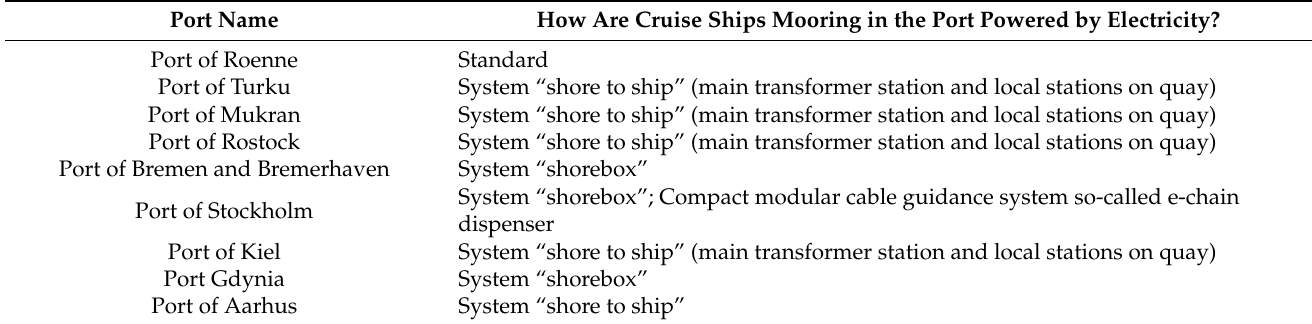
Table 3. Power supply services for cruise ships at berth in the surveyed ports in Northern